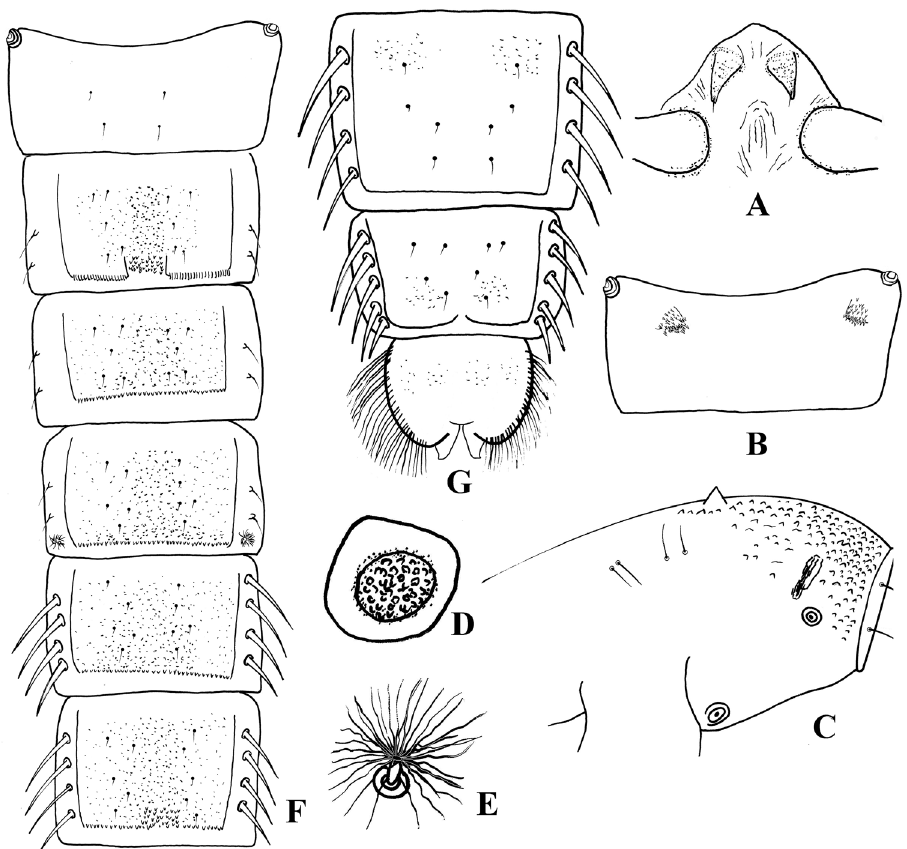
Figures 10. Harnischia sp.1. Pupae. A frontal apotome B sternite I C thorax, lateral view D basal ring E thorax horn F tergites I–VI G tergite VII–VIII and anal lobe.